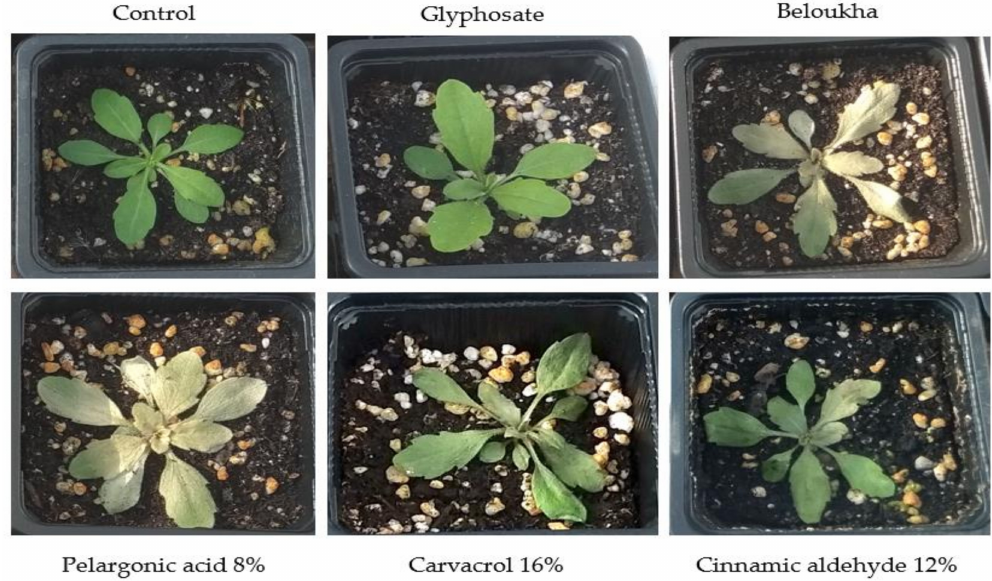
Figure 10. Images of Erigeron bonariensis plants 24 h after treatment applications.